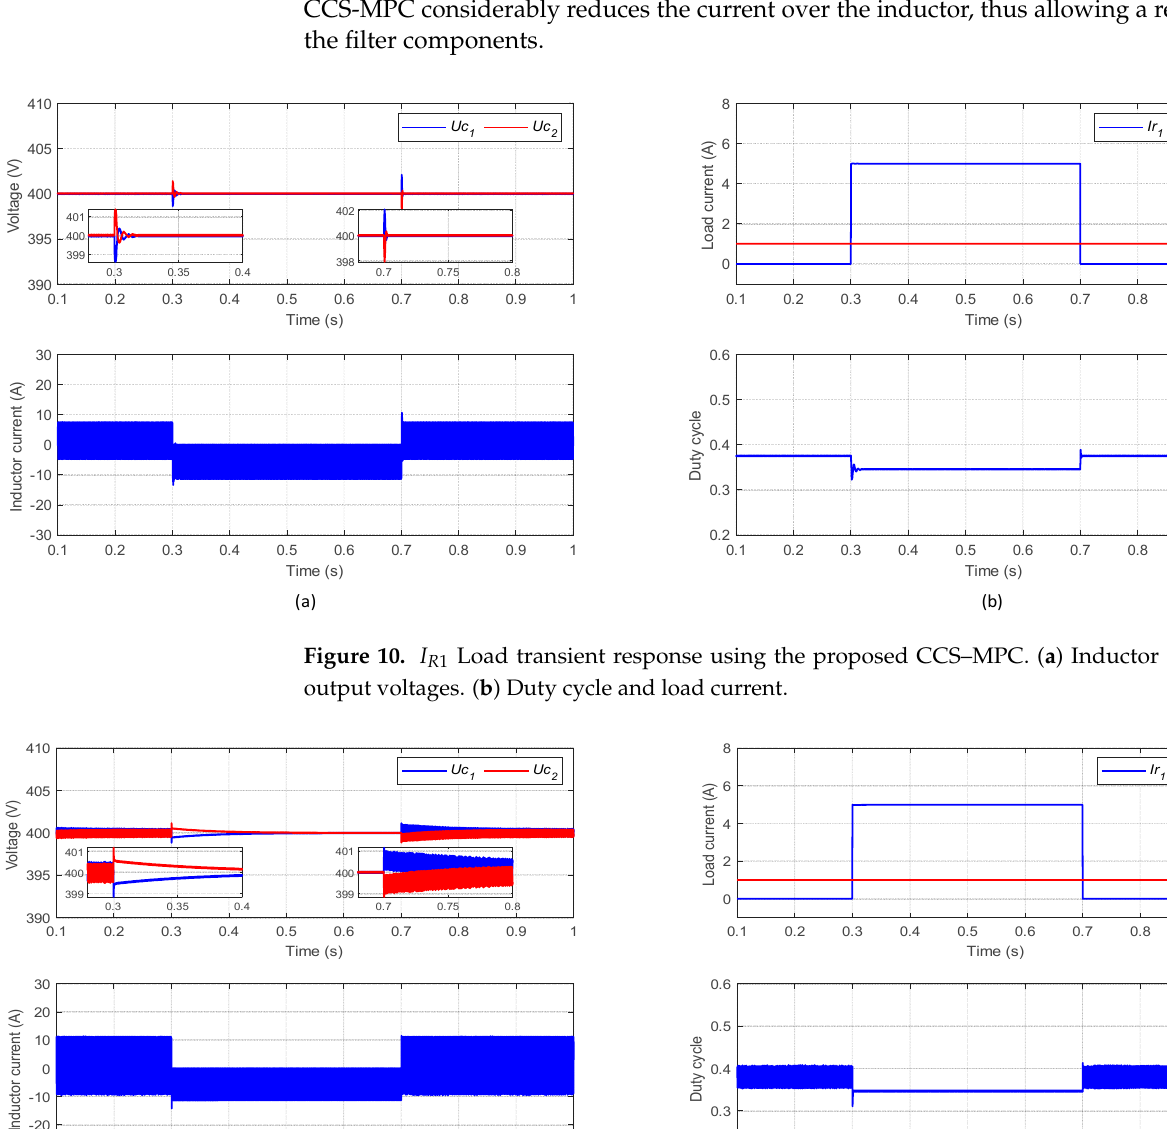
(b) Figure 12. Numerical results with 50% inductance nominal value using the proposed CCS – MPC. ( a ) Inductor current and output voltages. ( b ) Duty cycle and load current.